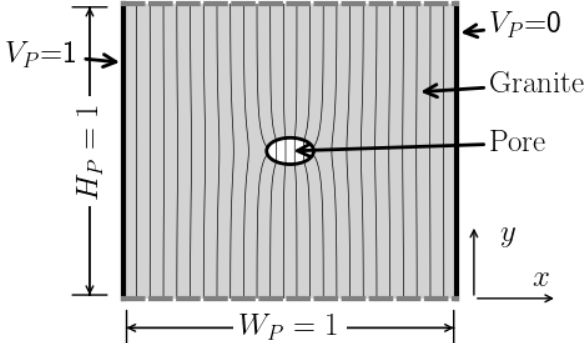
Figure 3. The pore-scale simulation domain. The single pore occupies 1% of the square area. The contours represent the equipotential lines, where “potential” refers to the electric